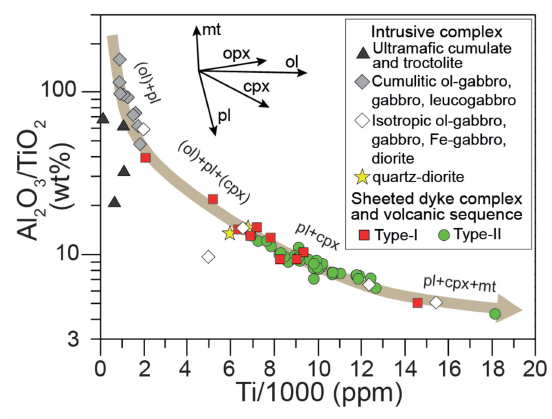
Figure 6. Al 2 O 3 / TiO 2 vs. Ti / 1000 diagram for magmatic rocks from the Band-e-Zeyarat ophiolite. Arrows show the fractional crystallization trends of magnetite (mt), orthopyroxene (opx), olivine (ol), clinopyroxene (cpx), and plagioclase (pl).